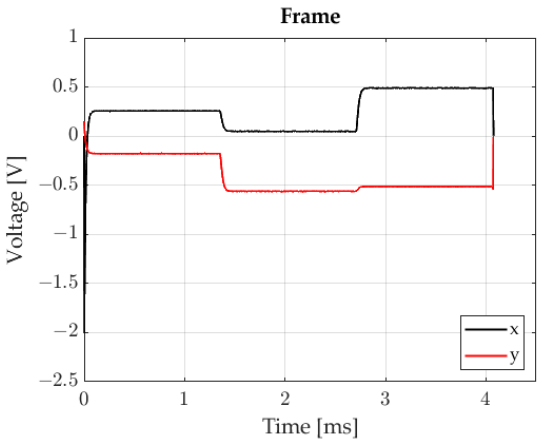
Figure 7. X and Y Figure 7. X and Y waveforms.